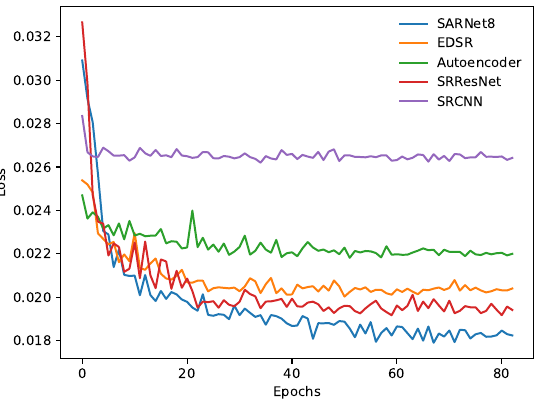
Figure 9. Network convergence comparison. SARNet8 provides the best results.